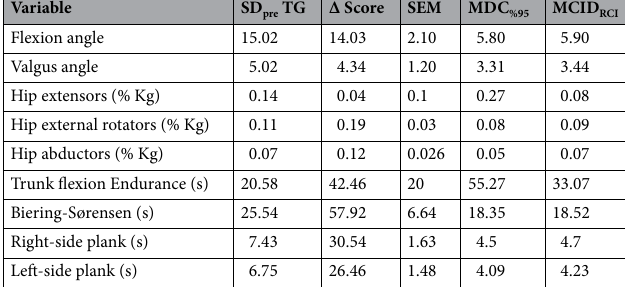
Table 3. The MDC and MCID values of the study